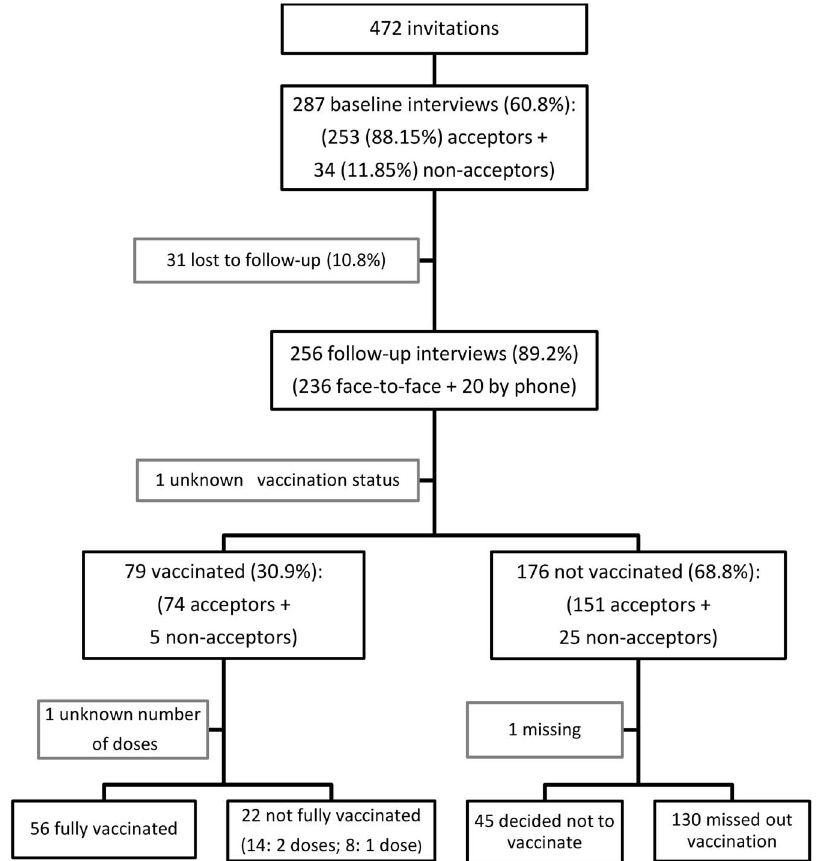
Figure 1. Flow diagram of participation in a longitudinal study, measuring baseline acceptance and subsequent uptake of the HPV vaccine.